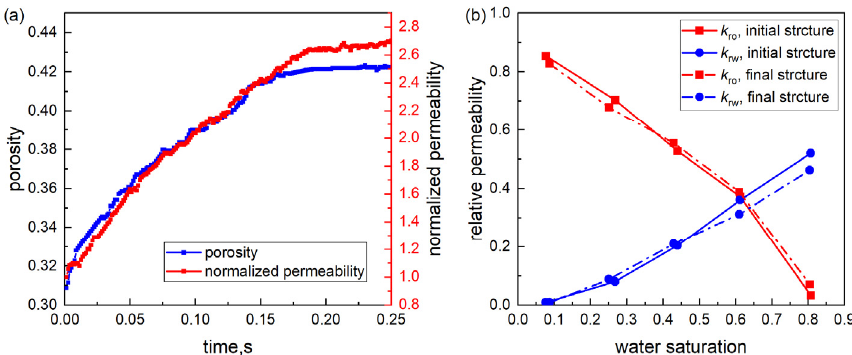
Figure 10. ( a ) porosity and normalized permeability change over time for porous media. ( b ) com- parison of relative permeability for porous media at the initial and final steps.